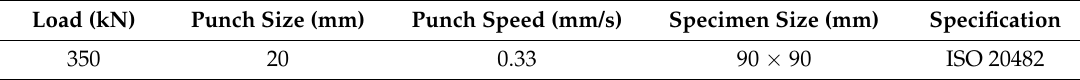
Table 2. The conditions of the Erichsen test used in the present